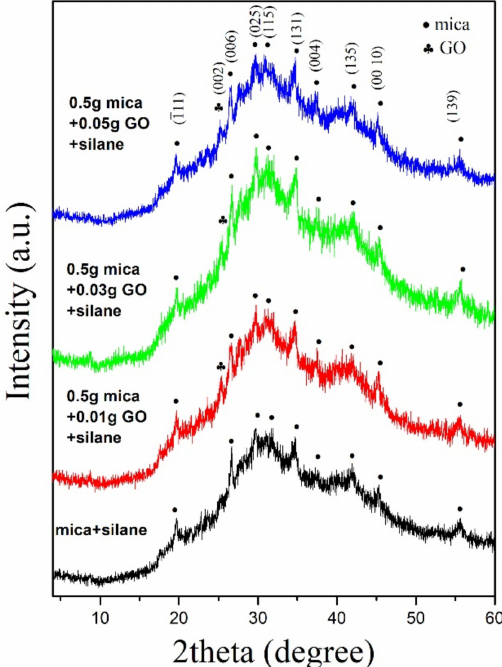
Figure 4. X-ray diffraction (XRD) patterns of silane-functionalized mica and mica/graphene oxide.